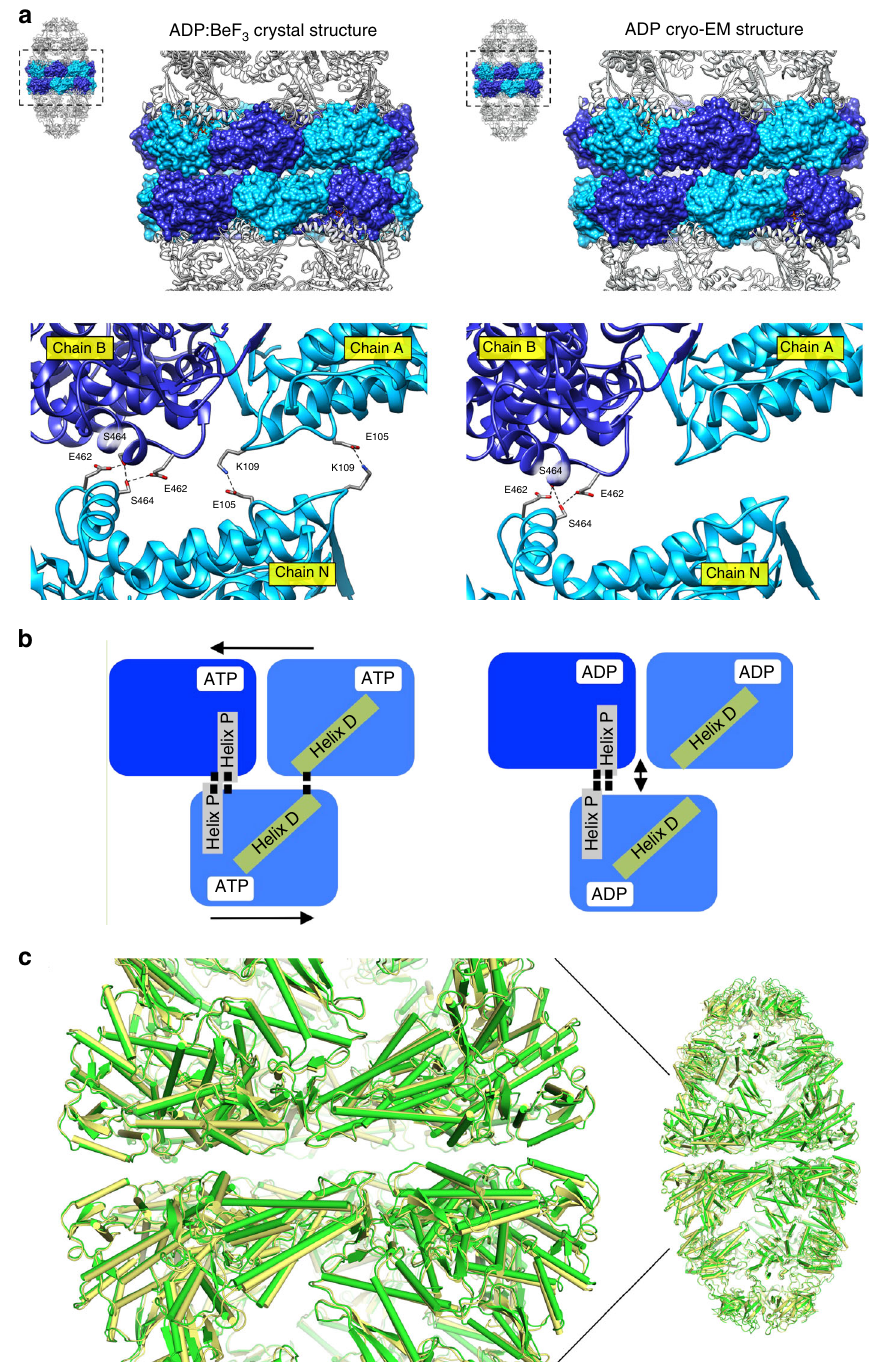
Fig. 4 mHsp60 inter-ring interface of mHsp60 – mHsp10 football complexes. a Side views of the ADP:BeF 3 (left) and the ADP (right) footballs. The equatorial domains of the mHsp60 subunits are rendered as a molecular surface in alternating blue and light blue. The other domains in the mHsp60 subunits and mHsp10 subunits are presented as ribbon diagrams. Below is a close-up view of the staggered arrangement of two mHsp60 subunits in one ring contacting one subunit in the opposite ring represented as ribbon diagrams. Residues engaged in inter-ring contacts are presented as sticks. In the ADP:BeF 3 football, these are E105, K109, E462, and S464 (left). In the ADP football, these are S464 and E462 (right). Black dashed lines denote bonds between the interacting residues. b Cartoon representing the differences in the interactions between left (Helix D) and right (Helix P) contact sites of the mHsp60 subunits across each ring of the ADP:BeF 3 (left) and ADP (right) footballs. c Superposition of the ADP:BeF 3 (green) and ADP (yellow) football structures showing a close-up of the mHsp60 inter-ring